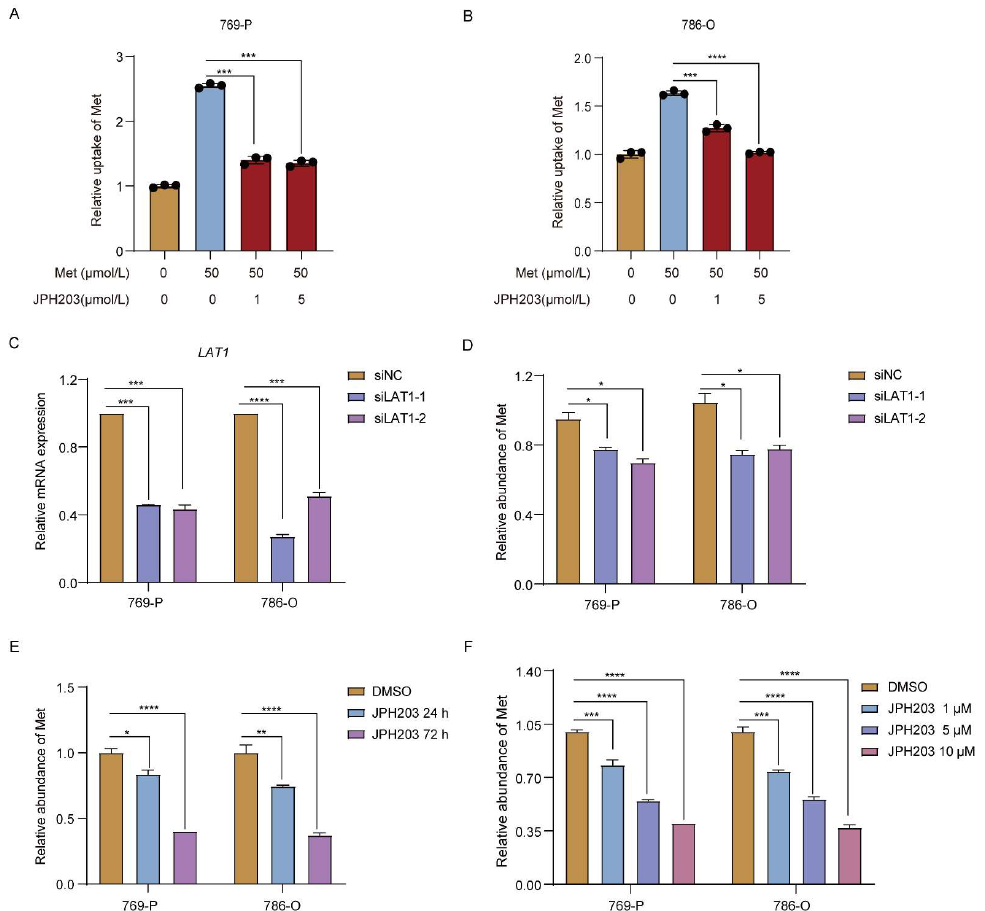
Figure 2. LAT1 regulates methionine accumulation in RCC cells. ( A , B ) The uptake of methionine was detected by LC-MS in 786-O ( A ) and 769-P ( B ) after being incubated with 50 µmol/L methionine with JPH203 (0, 1, and 5 µmol/L) at 37 °C for 3 min. ( C ) Expression of LAT1 in 786-O and 769-P cells after being treated with LAT1 specific siRNAs. GAPDH was used as the normalizing gene. ( D ) The methionine accumulation in 786-O and 769-P cells after being treated with LAT1 specific siRNAs for 48 h. ( E ) Methionine accumulation in 786-O and 769-P cells after being treated with 10 µmol/L JPH203 for 24 h and 72 h, respectively. ( F ) Intracellular methionine accumulation in 786-O and 769- P cells after being treated with JPH203 (0, 1, 5, and 10 µmol/L) for 72 h. Met—Methionine. Data are the mean ± SEM for biological triplicates. One-way ANOVA analysis was used. * p < 0.05; ** p < 0.01; *** p < 0.001; **** p < 0.0001. 3.3. LAT1 Could Be an Indicator for Grades and Overall Survival of RCC Given the close relation between the hypoxic microenvironment and RCC progres- sion [29], the overall survival and LAT1 expression for RCC patients was analyzed based on The Cancer Genome Atlas (TCGA) database [30]. As shown in Figure 3C, clinical